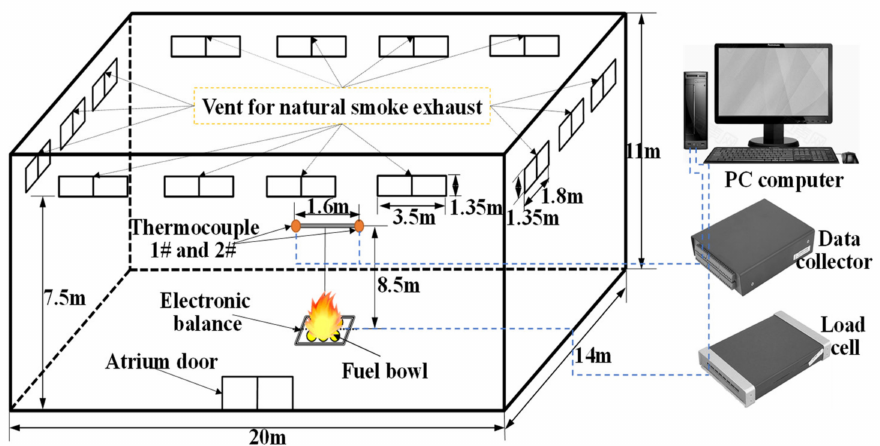
Figure 3. Experimental